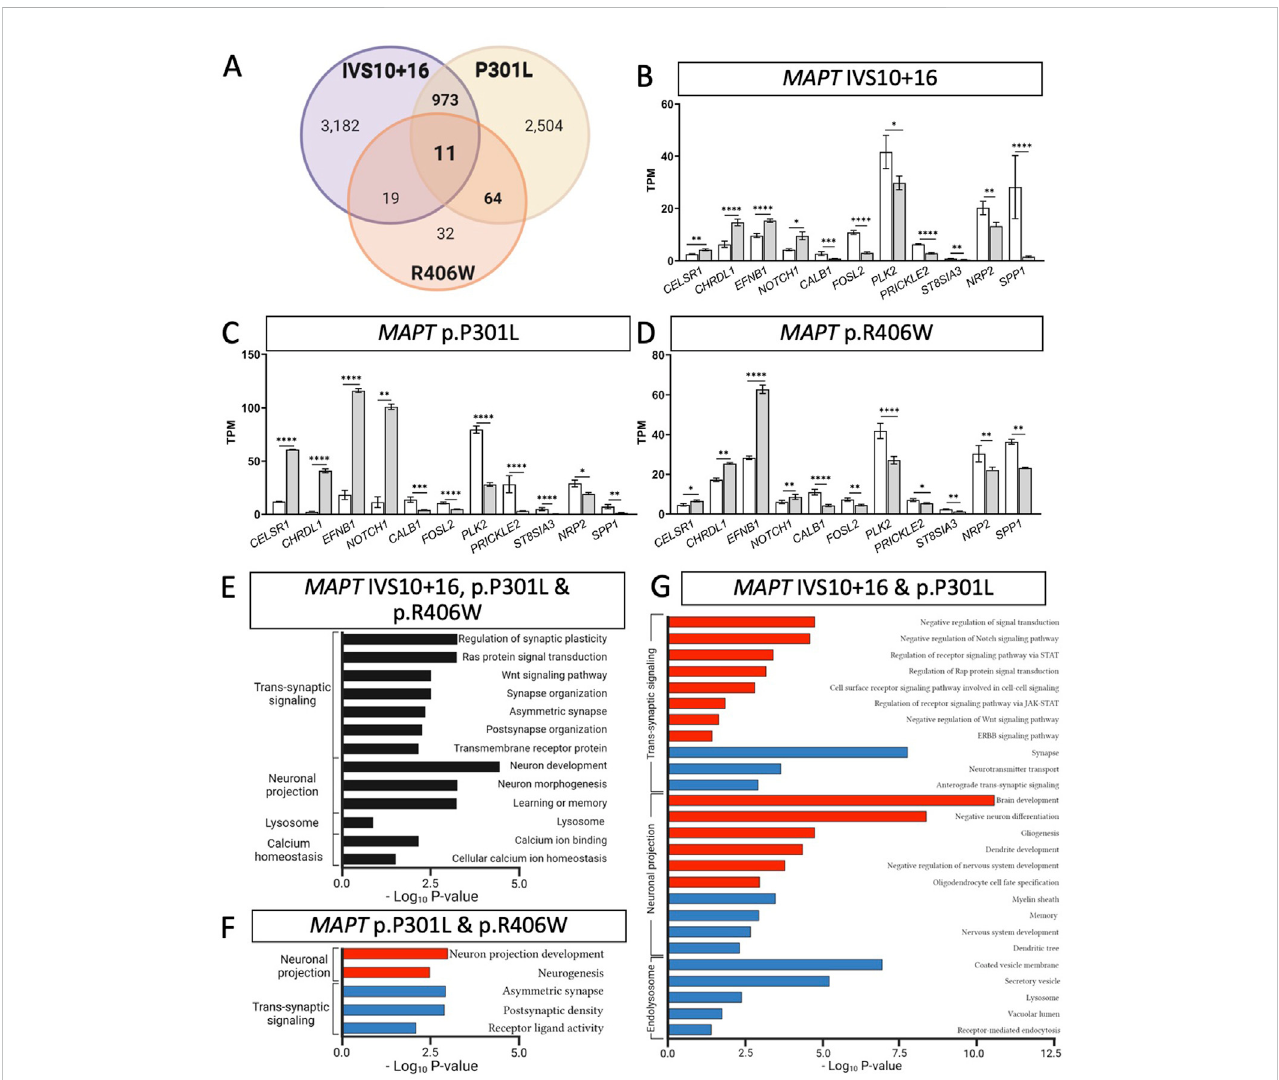
FIGURE 3 MAPT mutations result in common defects in synaptic signaling, neuronal projection, and lysosomal function. (A) Venn diagram presenting the differentiallyexpressedgenescommonamongiPSC-neuronscarrying MAPT IVS10+16,p.P301Landp.R406Wmutations(BY-FDR ≤ 0.05). (B – D) Normalized TPM expression of 11 genes shared between the three datasets ( MAPT- IVS10 + 16, p.P301L and p.R406W; BY-FDR ≤ 0.05). (E) Bar graph showing the most signi fi cant pathways enriched among the 11 shared differentially genes (black bars). (F) Bar graph of the pathways enriched among the genes shared between MAPT p.P301L and p.R406W neurons. (G) Bar graph of the pathways enriched among the genes shared between MAPT IVS10 + 16 and p.P301L neurons. (F – G) Pathways from up-regulated genes (red bars). Pathways from down-regulated genes (blue